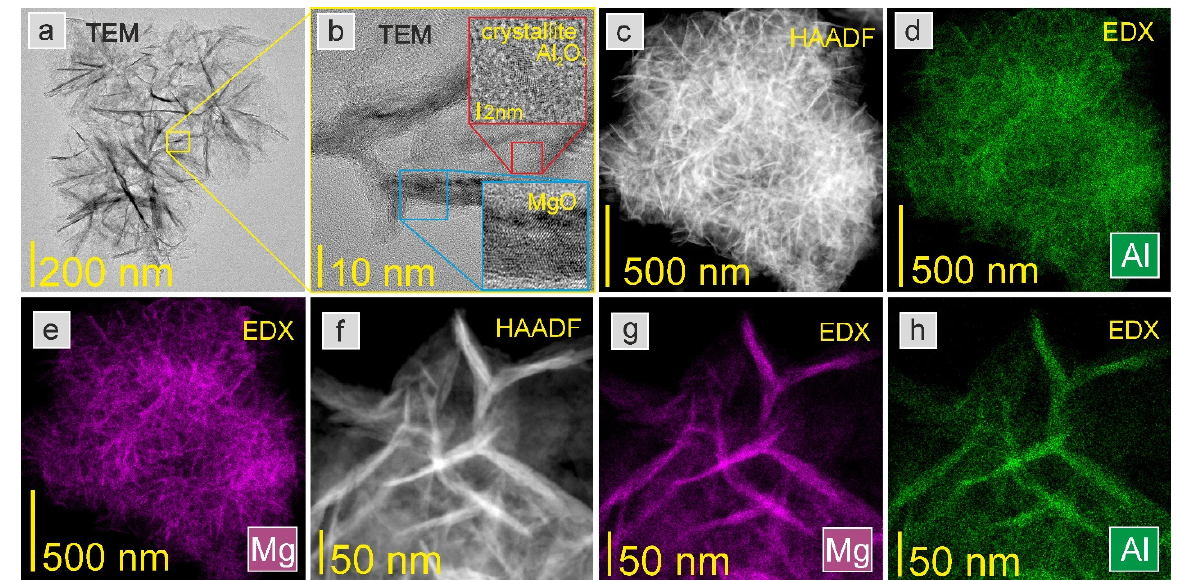
Figure 4. ( a ) TEM image of the 5Mg-Al support with ( b ) an enlarged fragment showing the polycrystalline structure of the compounds (MgO and Al 2 O 3 ). The crystallite Al 2 O 3 and the nanorod-like MgO nanostructure were presented in the inset. ( c ) STEM-HAADF image and EDX mapping presenting a uniform distribution of the elements: ( d ) aluminium and ( e ) magnesium. ( f ) STEM-HAADF image of the enlarged fragment of the 5Mg-Al support and corresponding EDX investigation of the distribution of elements: ( g ) magnesium and ( h ) aluminium.